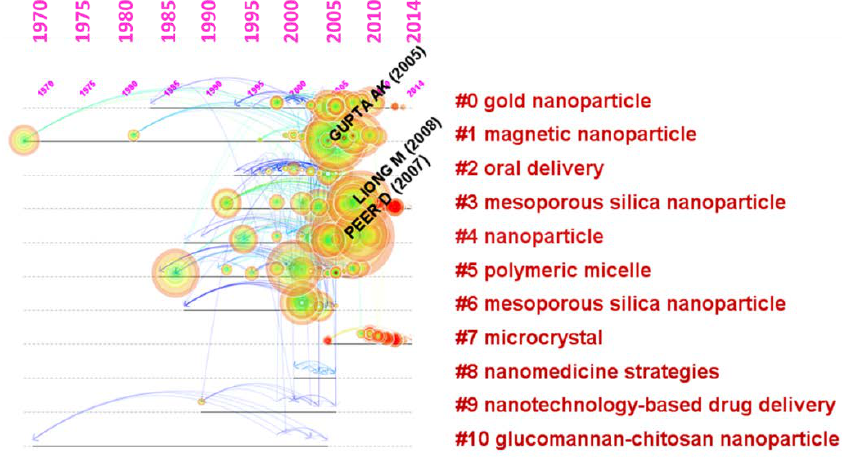
Figure 3. Timeline view for nanoparticle drug delivery technologies: 2005–2014.